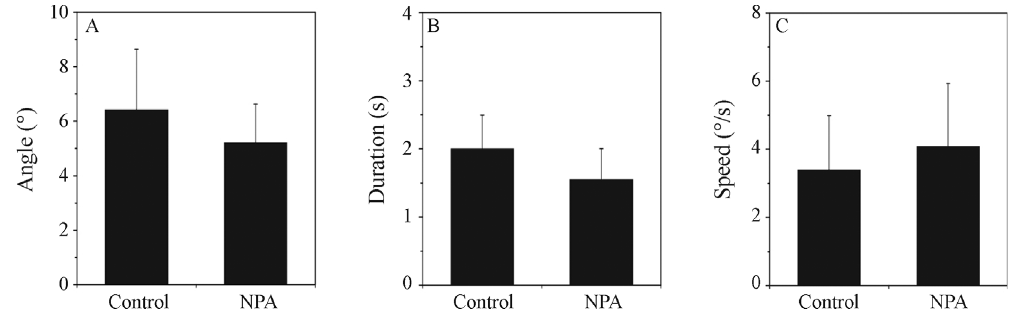
Figure3 -EffectofsprayingNPAonopenedflowers.(A)Movementamplitudemeasuredbytheangleformedbetweentheinitialstate(beforethemove- ment)andthefinalstate(afterthemovement)indegrees.(B)Durationofthemovementinseconds.(C)Angularspeedofthemovementindeg/s.Thedata shows that only spraying NPA is not sufficient to cause alteration in the androgynophore